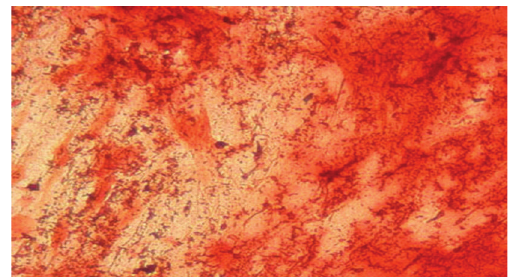
Figure 7: Calcium salts were red when stained by Alizarin S (100 × ).